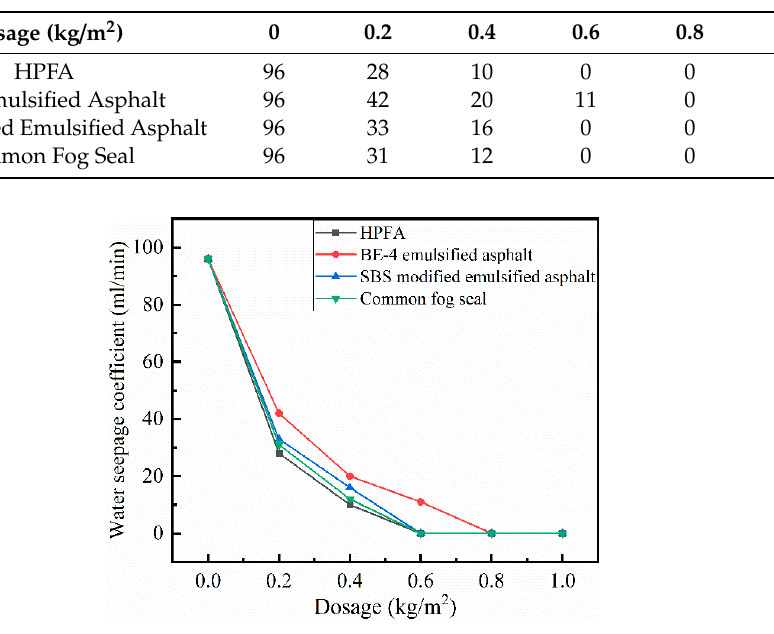
( b ) ( c ) Figure 21. Construction technology: ( a ) one oil and one sand; ( b ) two oils and one sand; ( c ) premix.